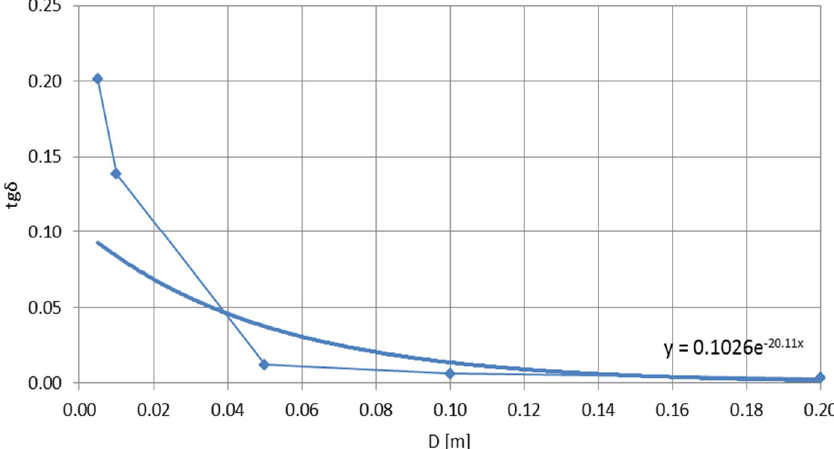
Figure 9. The conductivity of the Glacier Paradise ice measured with increasing distance between the probes.